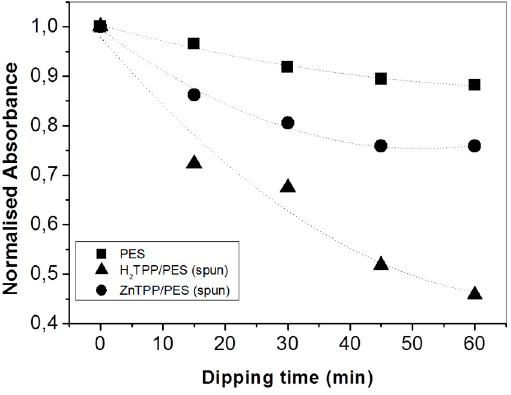
Figure 6. Normalized absorbance decrease of p-NA solution ( λ = 381 nm) upon increasing the dipping of the time of untreated and porphyrin / PES electrospun mats. The initial concentration of p-NA was 5 µ M. Squares, circles, and triangles refer to untreated PES, ZnTPP / PES, and H 2 TPP / PES fibers, respectively.